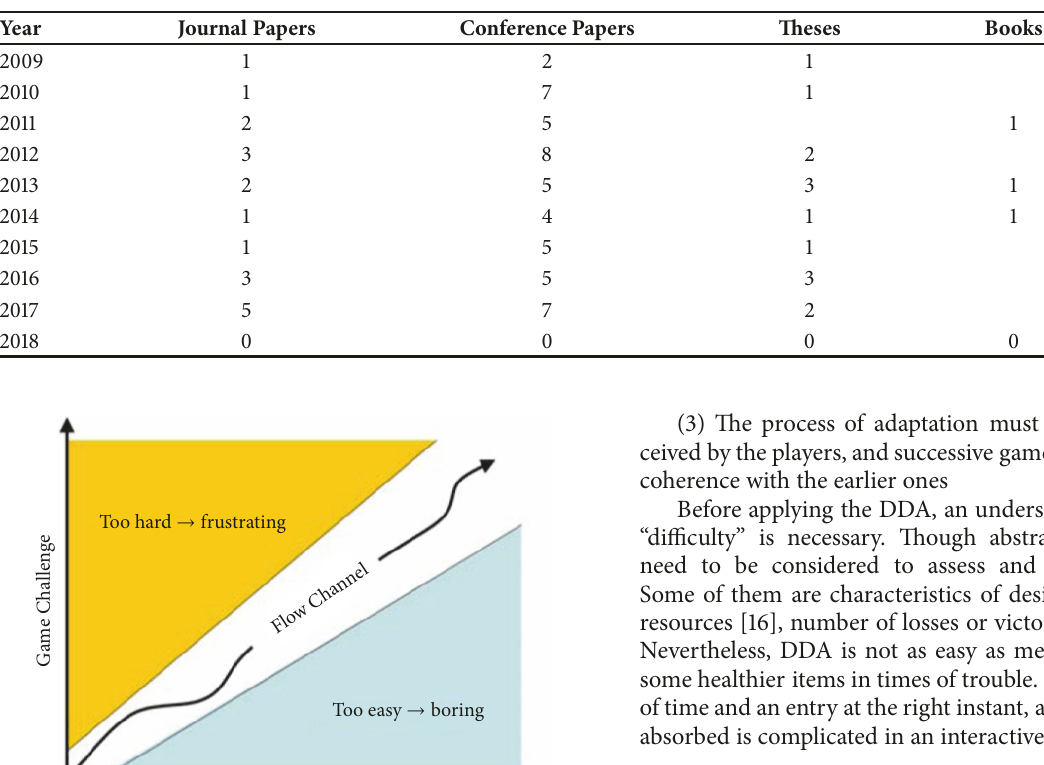
Table 1: DDA research studies since 2009.